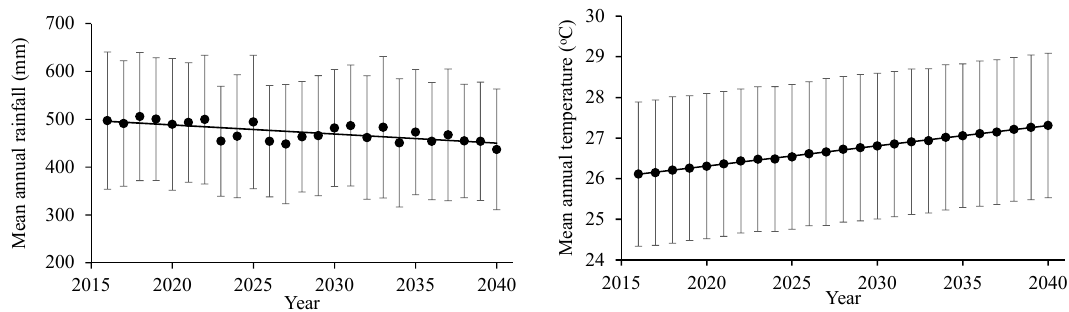
Figure 2. Mean annual rainfall and air temperature together with trendlines ± standard deviations of 100 stochastic daily data series associated with rainfall reduction and air temperature increase simulated for 2016–2040 relative to 1990–2015.